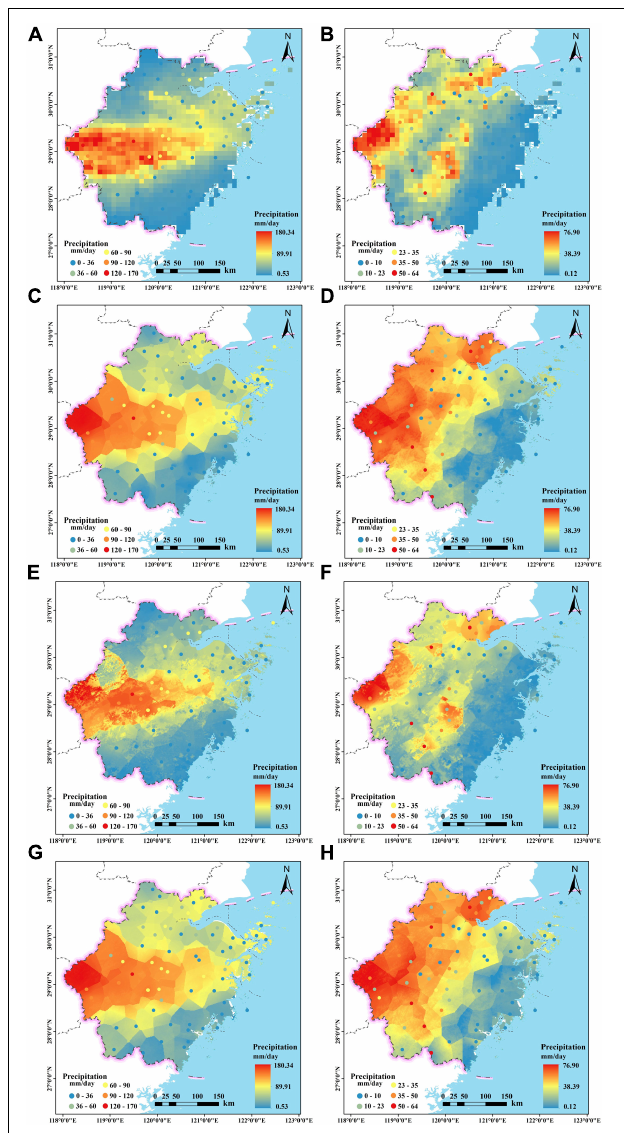
FIGURE 7 | The spatial patterns of (A,B) the original IMERG in event 1 and event 3, (C,D) BPNN-based downscaled results in event 1 and event 3, (E,F) SVM-based downscaled results in event 1 and event 3, and (G,H) MLR-based downscaled results in event 1 and event 3 over Zhejiang